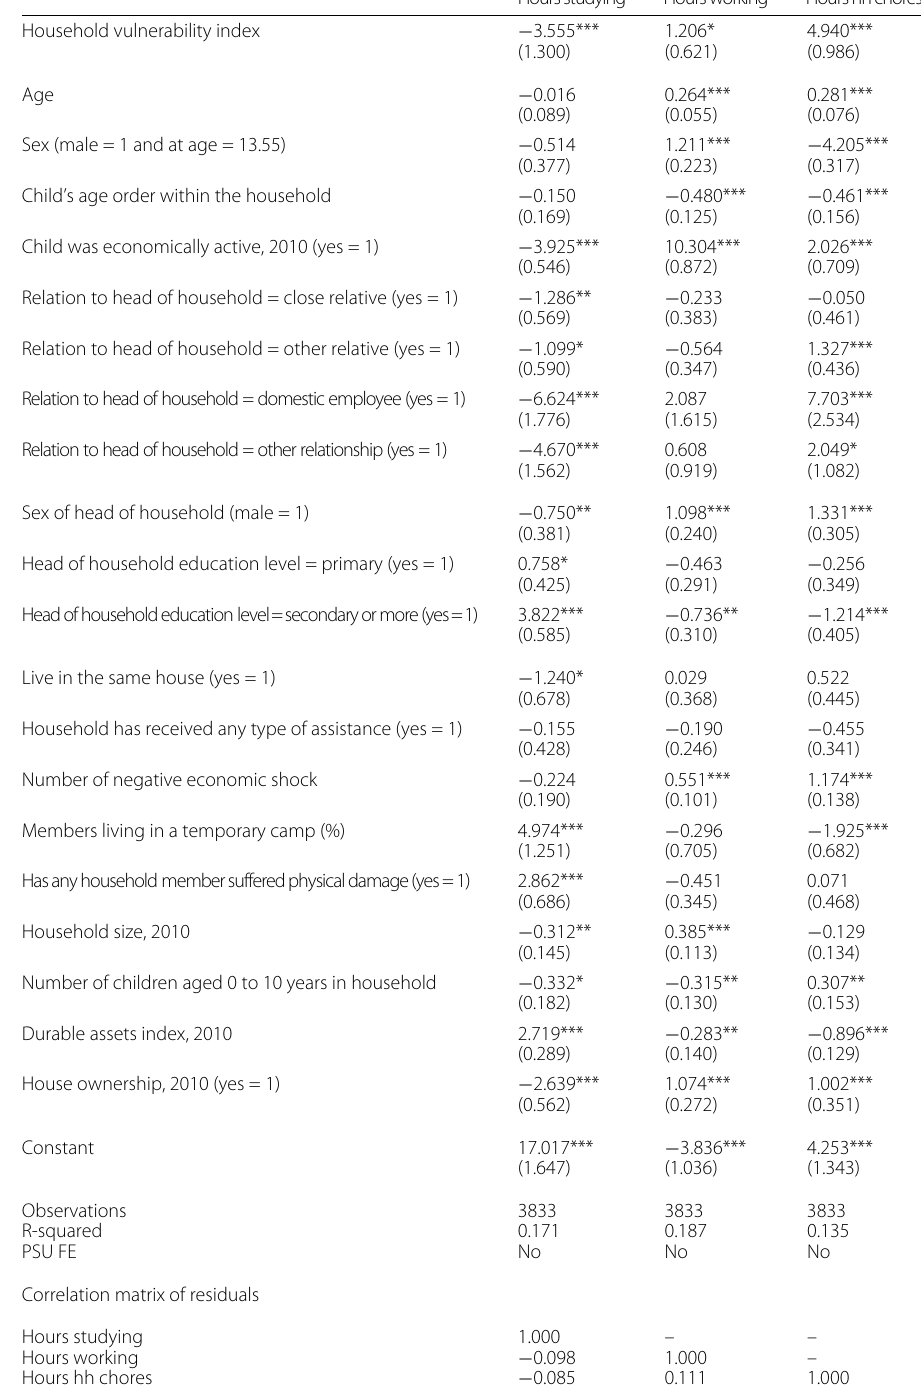
Table 4 SUR model for children’s time allocation